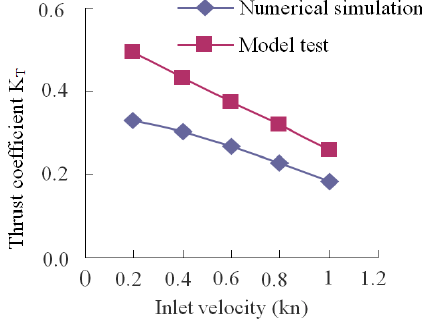
Figure 3. Example 2 comparison results.